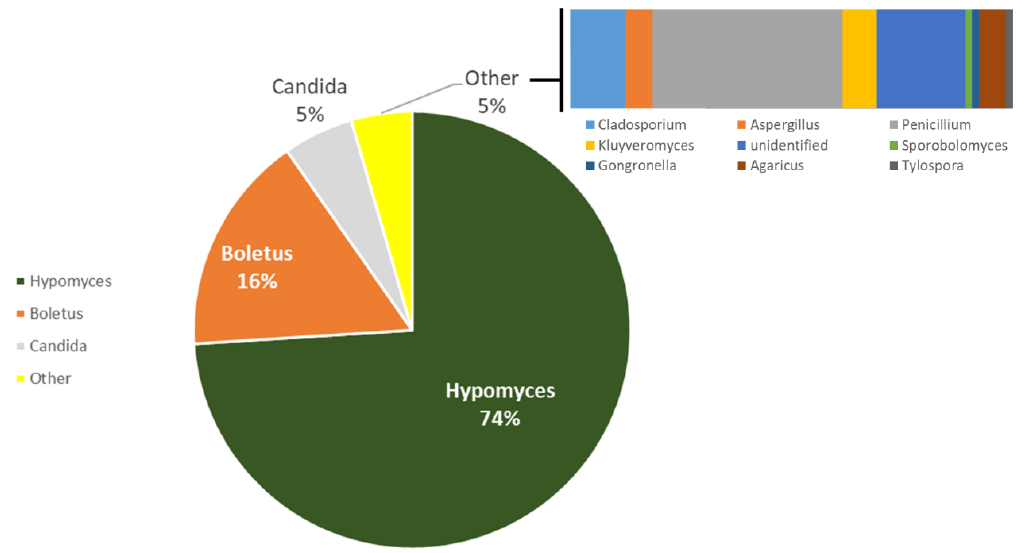
Figure 4. NGS evaluation of the microbial diversity of Escoural Cave. Fungal genus biodiversity.